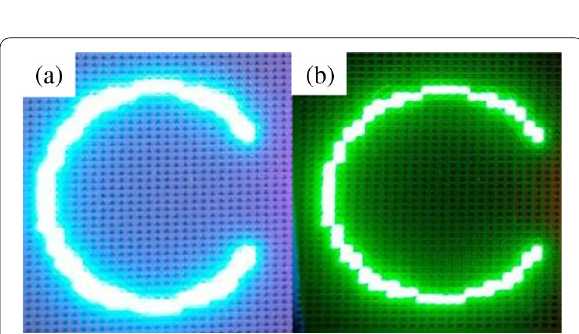
Fig. 11 Green QDs sample a before and b after addition of RCPEF